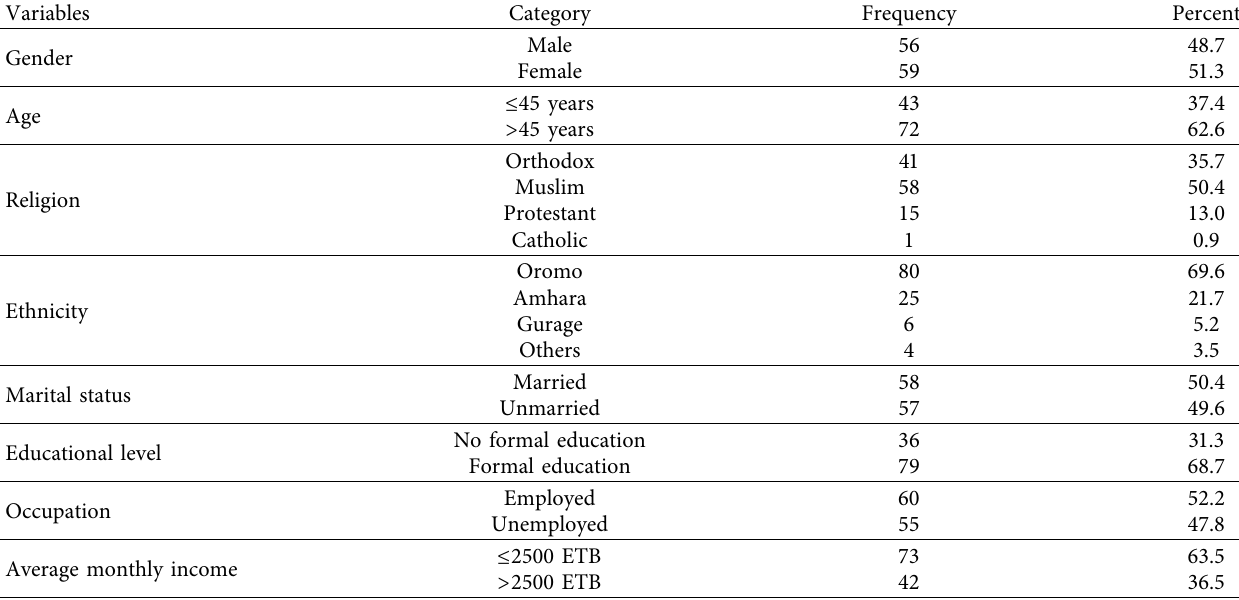
Table 1: Sociodemographic characteristics of hypertensive patients in a follow-up clinic of Asella Referral and Teaching Hospital, Asella Town, Arsi Zone, Oromia Regional State, Ethiopia, 2020 ( n � 115).